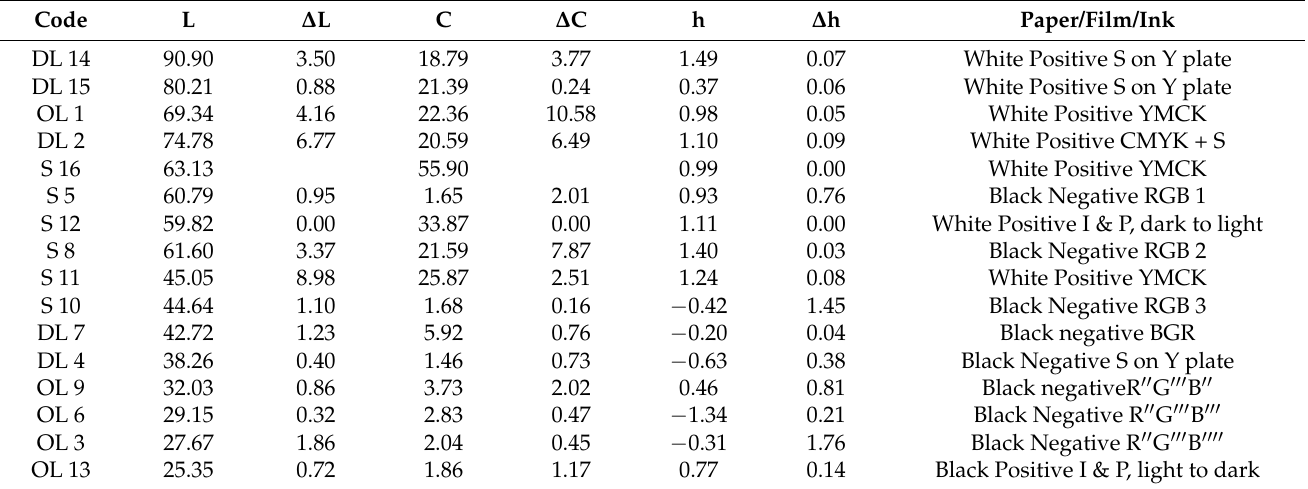
Table 12. Average luminosity, chroma and hue of all background spots. Ordered according to the higher luminosity value.